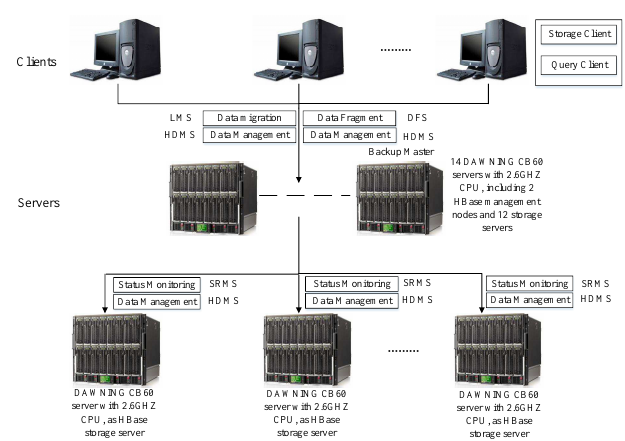
Fig. 8 Deployment of our system.